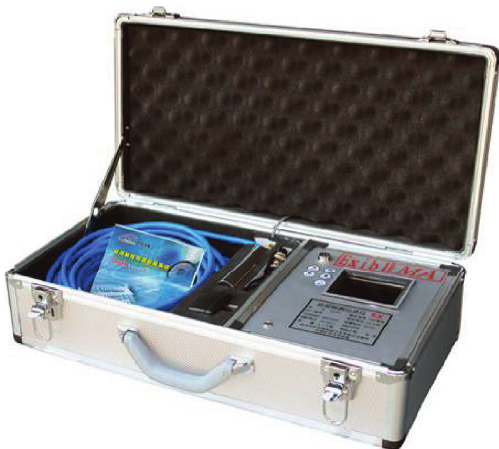
Figure 12: YTJ20 type rock exploration recorder.